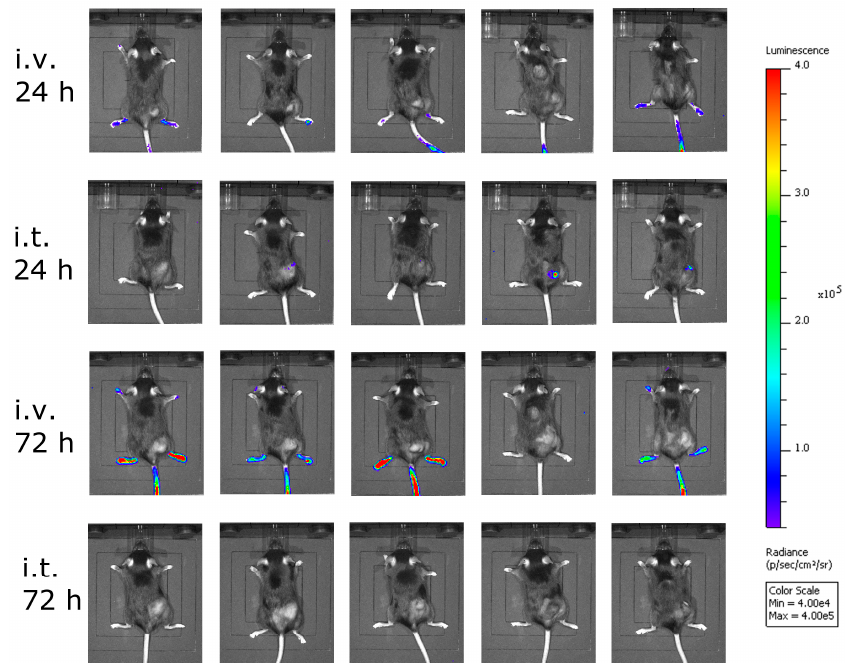
Figure 4. Less virus reached the tumor after intravenous virus application. B16-OVA cells were implanted subcutaneously into C57BL/6 mice. When tumors were palpable, mice were treated either intratumorally (i.t.) or intravenously (i.v.) with VSV-GP expressing luciferase. At 24 and 72 hours post-treatment, mice were analyzed for luciferase activity using in vivo imaging. Five mice per group were analyzed. Color code depicts luminescence as photons/second/cm 2 /steradian [p/s/cm 2 /sr].